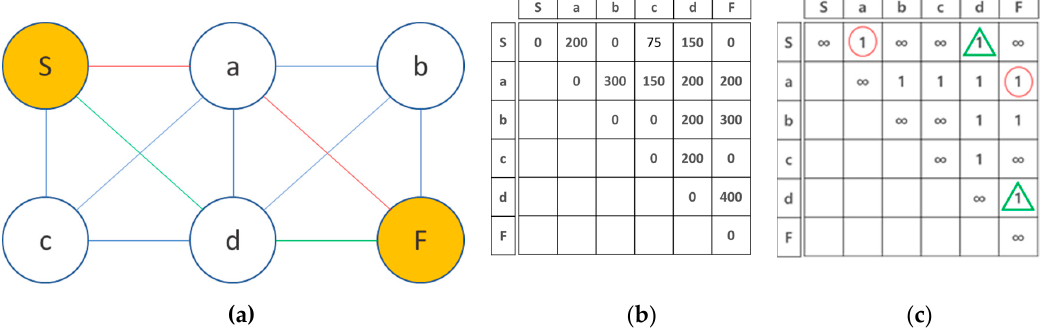
Figure 8. ( a ) An image network in an area, and the two shortest paths from image S to F (red and green lines); ( b ) the number of tie points between each image pair, and (c) the weight of the image pairs and the two shortest paths (red circles and green triangles).